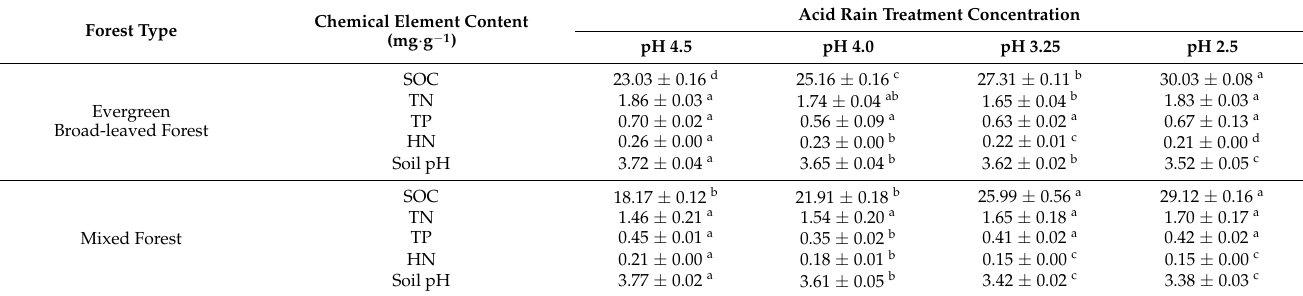
Table 4. Soil chemical properties under different acid rain treatments in